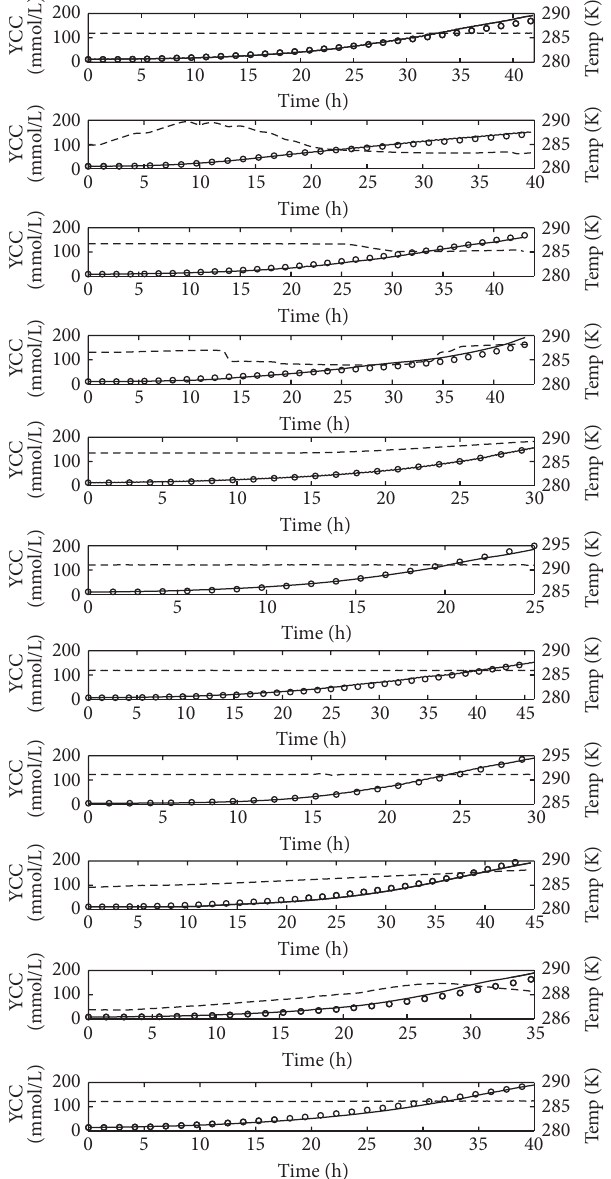
Figure 1: Comparison of cell count (YCC) of historical batches and model output. The circles (o) show the YCC model output in mmol/L, the solid line (—) is the experimental trajectory of YCC in mmol/L, and the dashed line (- - -) denotes the temperature in K. The duration, respectively, batch length, varied between 24 and 46 hours. Initial conditions of yeast cell concentration varied in between 4.1mmol/L and 14.9 mmol/L. The final state of the yeast cell concentration showed a range from 146.3 mmol/L to